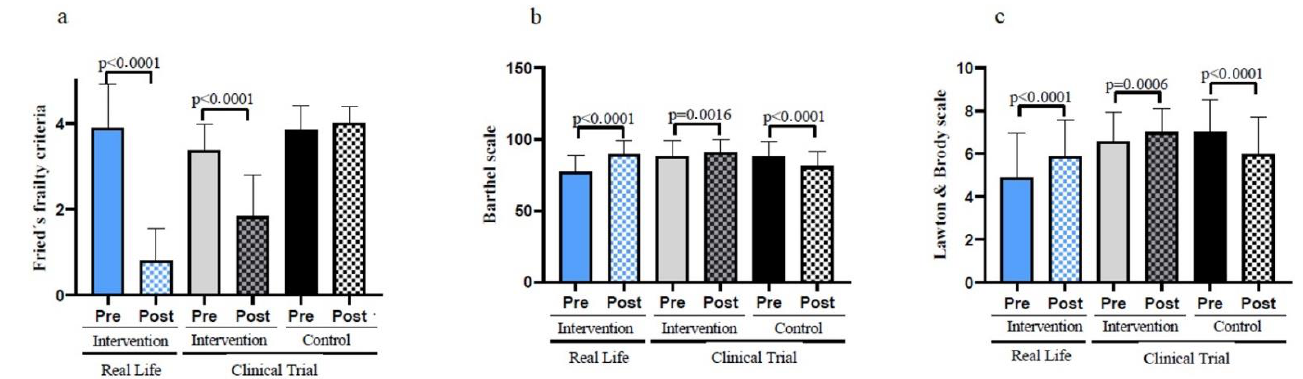
Figure 2. Functional parameters in old individuals before and after a six-months intervention. ( a ) Number of frailty criteria fulfilled by the participants before and after the Real-Life and the Clinical Trial interventions. ( b ) Performance in the basic activities of daily living using the Barthel Scale. ( c ) Performance in the instrumental activities of daily living using the Lawton & Brody Scale. Real-Life Intervention n = 50, Clinical Trial Intervention n = 51, Clinical Trial Control n = 49. Bars represent mean ± SD. Statistical analysis was performed with the Student’s t test for paired samples and the Wilcoxon test for non-parametric samples. Table 1. Changes in the main outcomes analyzed in our study before and after the interventions, Real-life and CT.